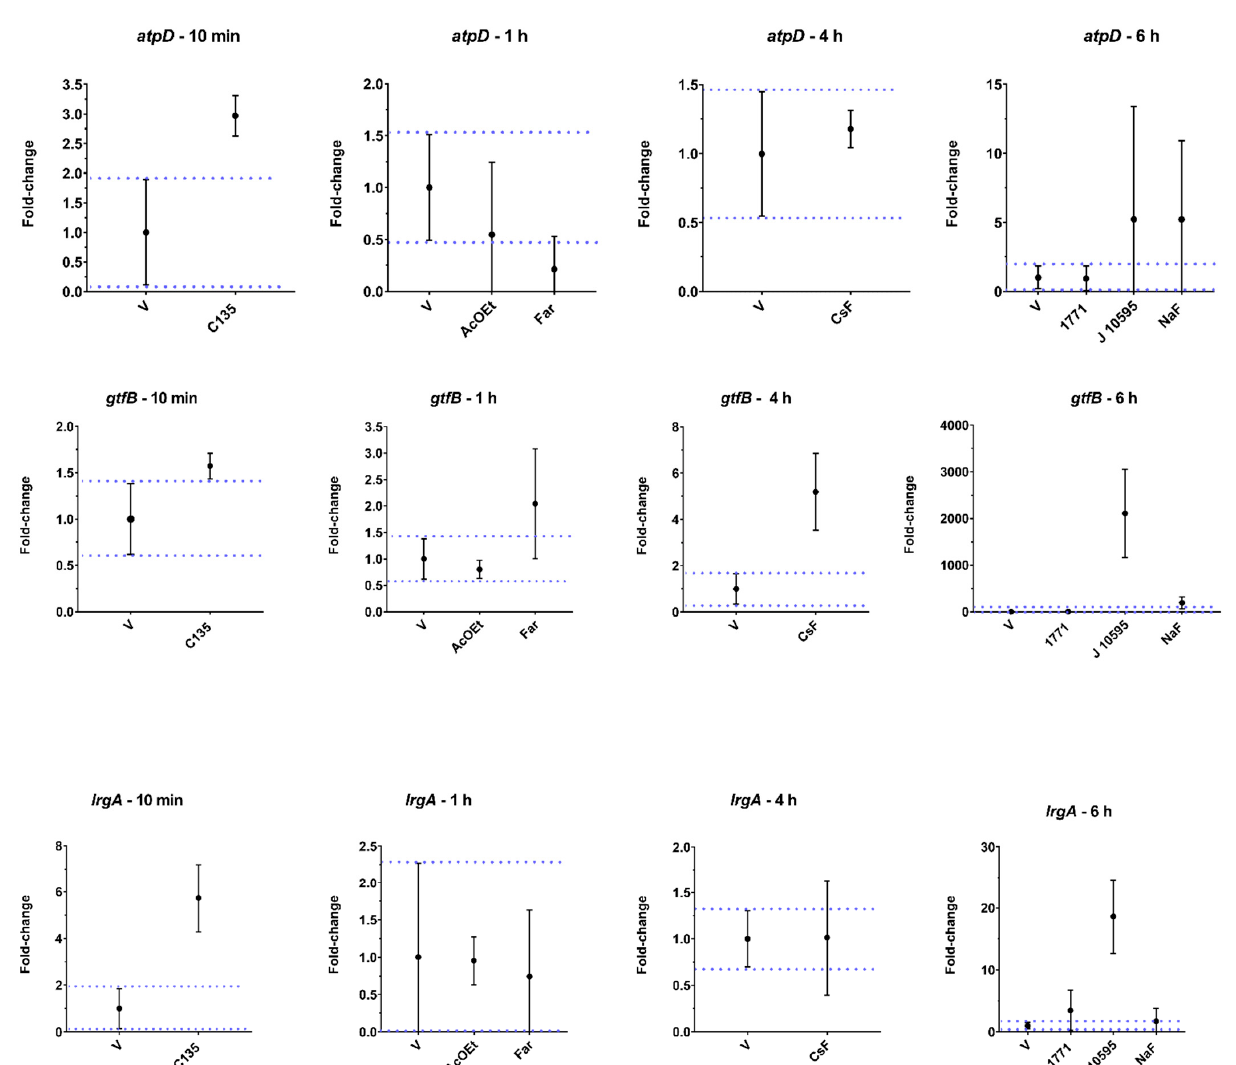
Figure 9. S. mutans gene expression of planktonic cultures treated with distinct agent. The central data are the mean, and the error bars are the confidence interval (95% CI). The dotted lines use vehicle data to compare the effectiveness of tested treatments. For detailed information, see the graph of gtfB at 6 h for 1771 vs. V in Figure A3.